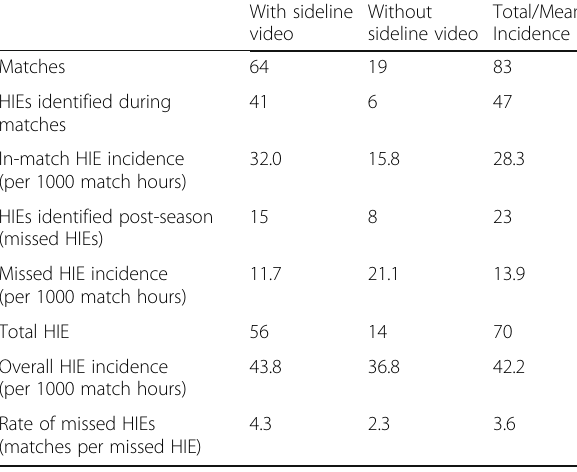
Table 3 Summary of HIEs with and without sideline video